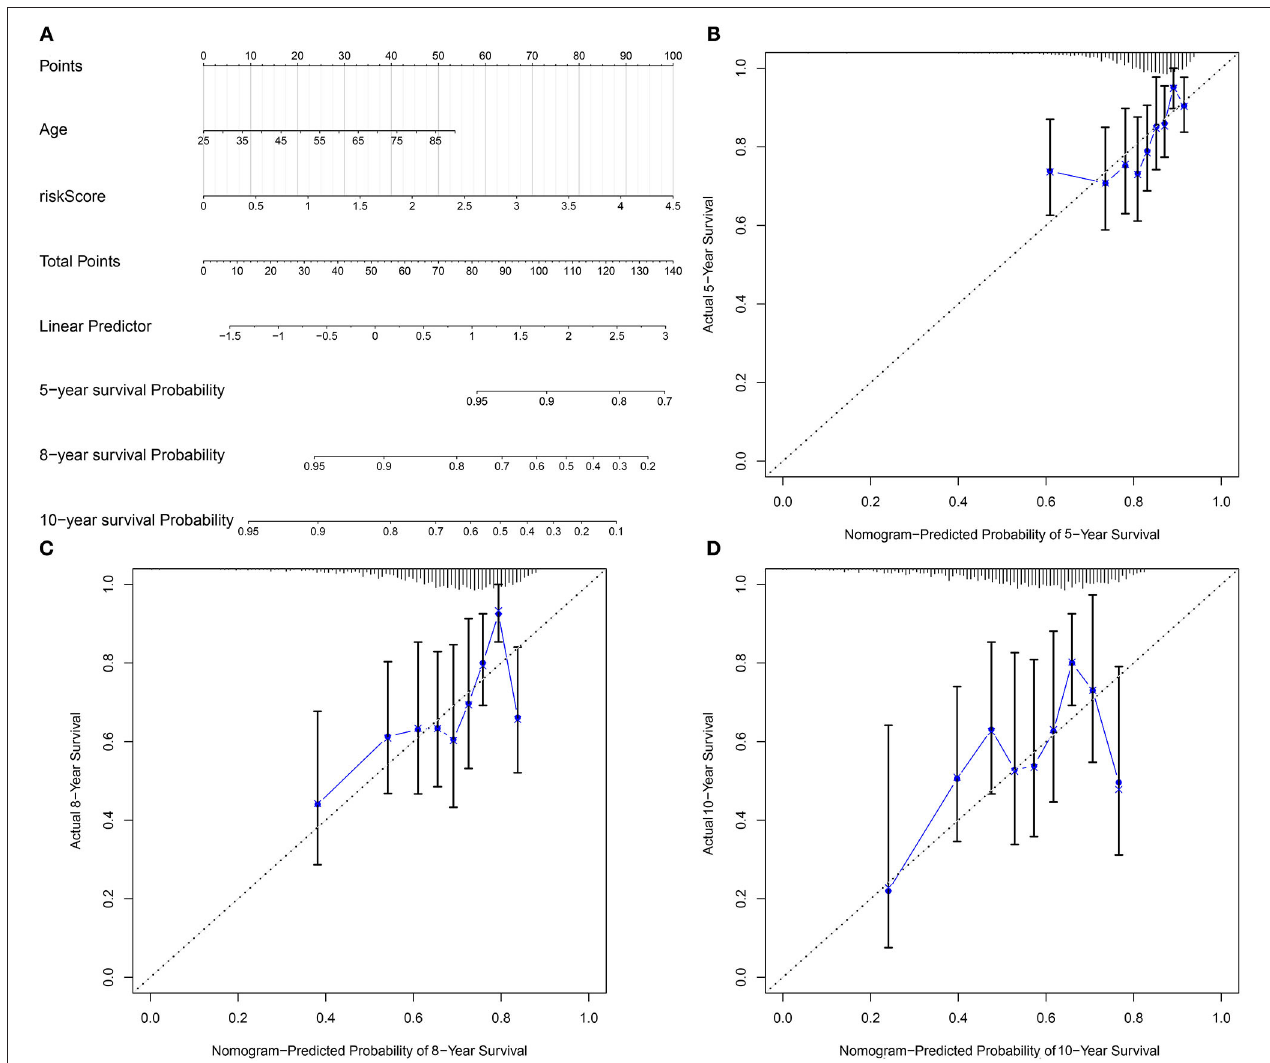
FIGURE 8 | Development of a nomogram for estimating 5-, 8-, and 10-year survival probabilities of breast cancer patients. (A) A nomogram incorporating age and risk score was a predictor of 5-, 8-, and 10-year survival probabilities. (B–D) Calibrate plots was applied for investigating the deviation in nomogram-predicted and actual 5-, 8-, and 10-year survival